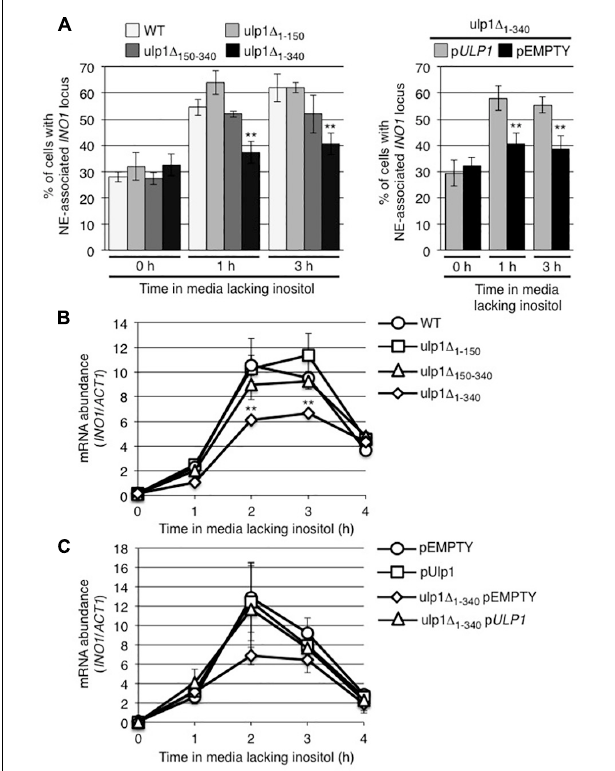
FIGURE 5 | Ulp1 is required for INO1 expression and NE-association following induction. (A) The percentage of cells showing NE-association of INO1-lacO 256 was determined as described in Figure 2 prior to (0 h) and at 1 and 3 h post induction in WT and the indicated ulp1 mutant strain backgrounds. Shown on the right are the results of similar experiments performed on a ulp1 (cid:49) 1 - 340 strain transformed with either an empty plasmid (pEMPTY) or a plasmid containing a version of WT ULP1 (p ULP1 ). Results are the means ± SD of three or more biological replicates. At least 50 cells were counted for each sample. (B,C) Levels of mRNA encoded by the INO1 gene were evaluated by qRT-PCR as described in Figure 2 following induction for the specified times in the indicated strains. Results are the means ± SEM of three biological replicates. Note, C shows data from the indicated strains transformed with either an empty plasmid (pEMPTY) or a plasmid containing a version of WT ULP1 (p ULP1 ). Asterisks indicate a significant difference from WT as indicated by a Student’s unpaired t -test, ** p < 0.01.